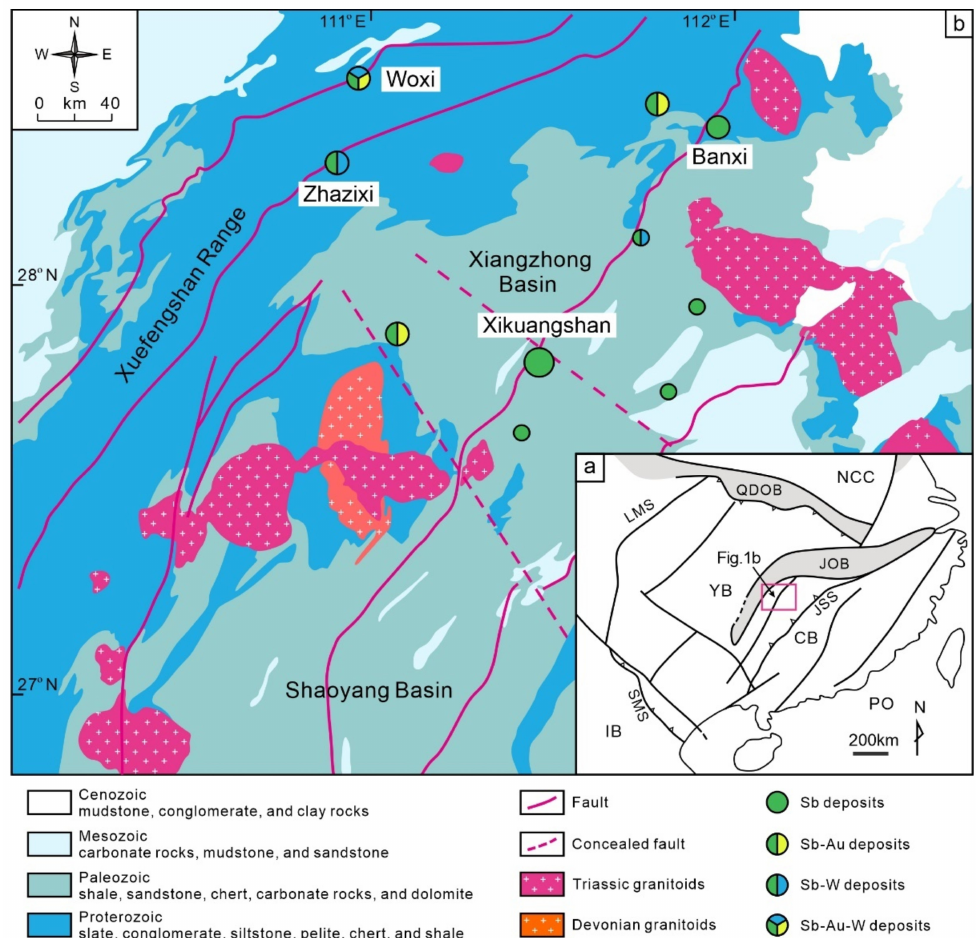
Figure 1. ( a ) Tectonic map showing the location of the Xiangzhong metallogenic province in southern China (modified after [21,22]). Symbols: NCC = North China Craton, QDOB = Qinling–Dabie Orogen Belt, LMS = Longmenshan Fault, JOB = Jiangnan Orogen Belt, YB = Yangtze Block, JSS = JiangShao Suture, CB = Cathaysia Block, SMS = Song-MA Suture, IB = Indochina Block, PO = Pacific Ocean. The thick black lines represent the main boundary faults. The serrated shape represents the suture zone. The thin black lines represent the coastline. ( b ) Regional geologic map of the Xikuangshan Sb deposit, showing the distribution of important Sb deposits in Xiangzhong metallogenic province (modified after